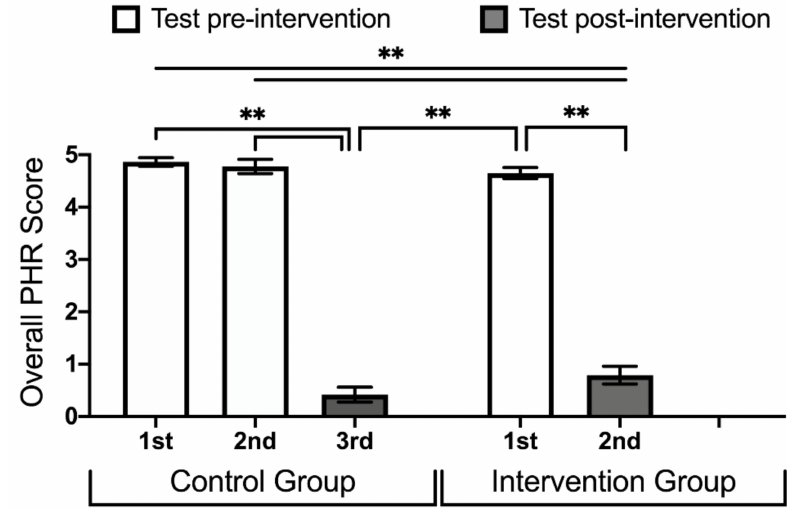
Figure 4. Average of the potential harmful response (PHR) score for each test taken on the intervention arm (two tests) and the control arm (three tests). White bars represent tests at baseline or after the implementation of the control program. Grey bars represent the results from the test after the intervention program. A Kruskal-Wallis test was used to evaluate statistical di ff erences. p -values were reported when < 0.05 (*) and < 0.01